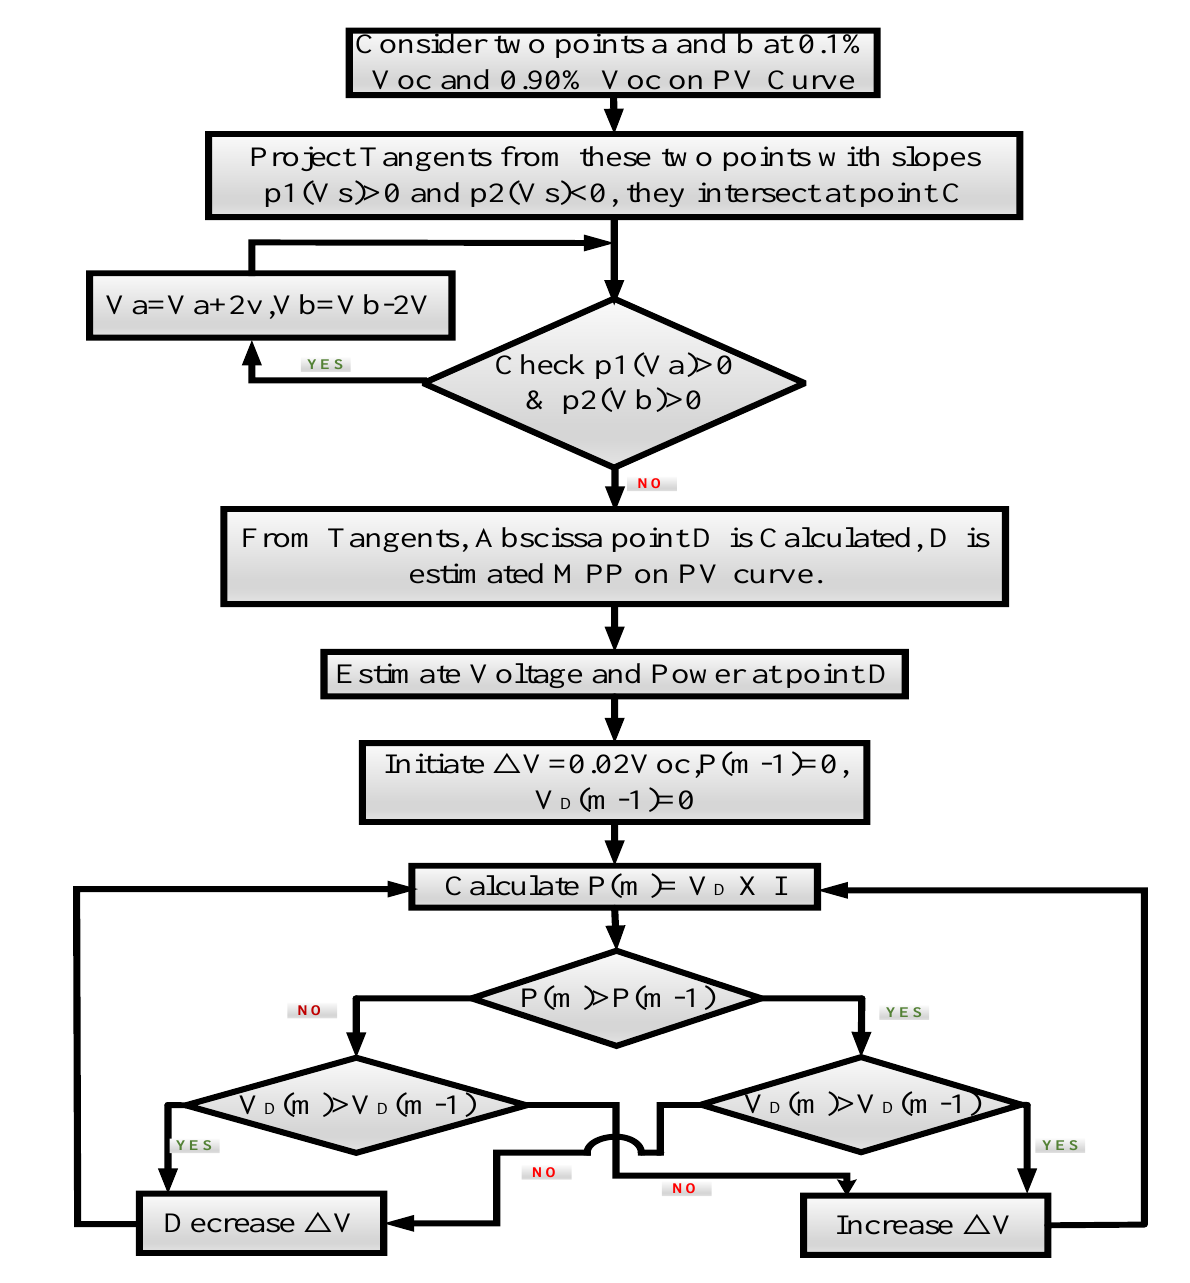
Figure 14. Flow chart for LT & O